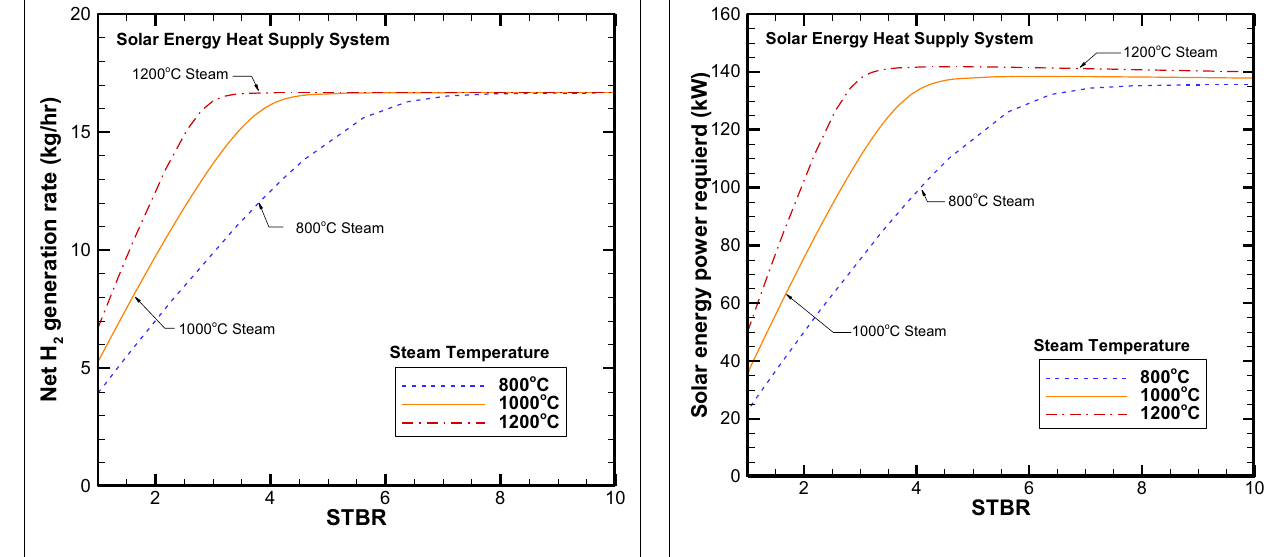
FIGURE 14 | Solar energy power required for concept system II as a function of STBR .